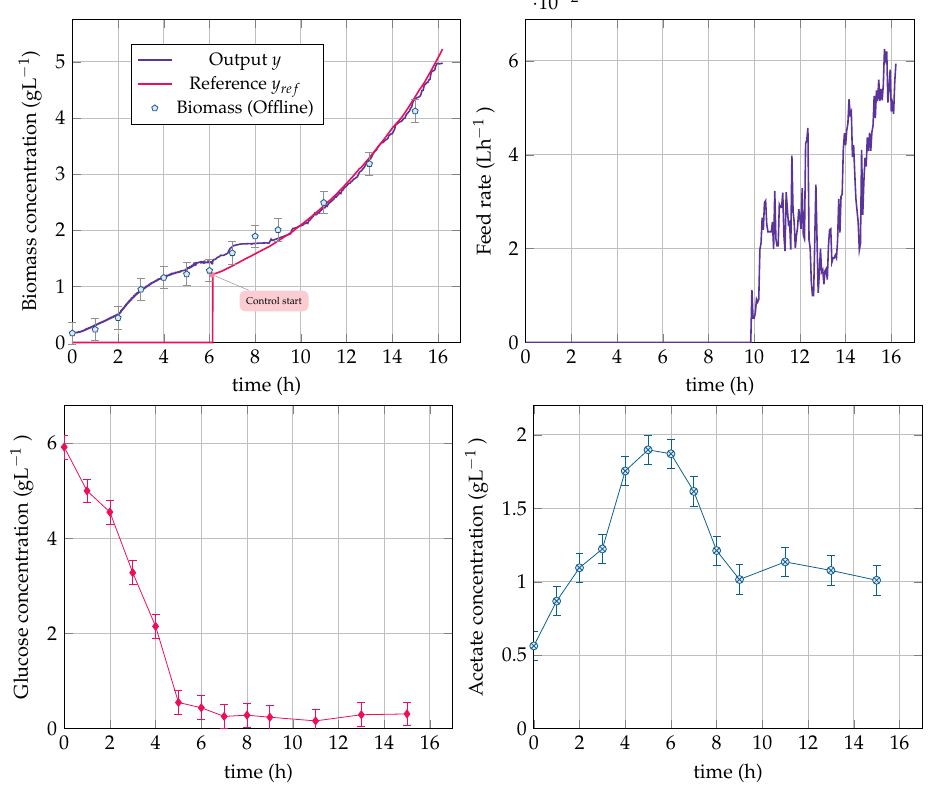
Figure 14. Experiment 1: Time evolution of the measured biomass, reference profile, glucose, acetate concentrations, and feed